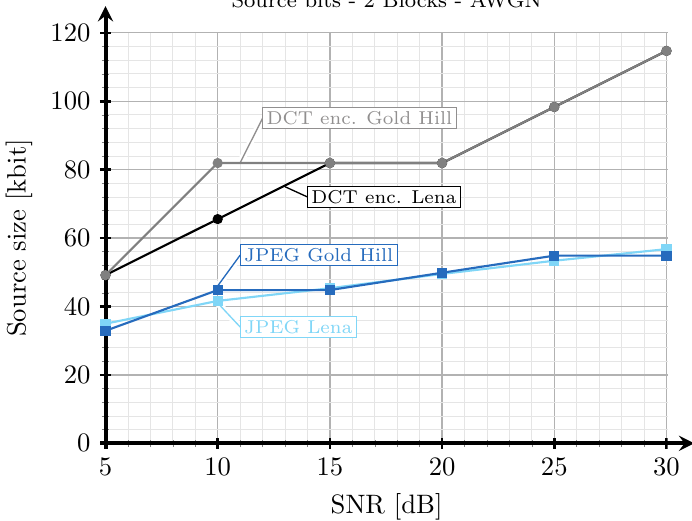
Figure 19. Source size vs. SNR for two blocks and AWGN channel.